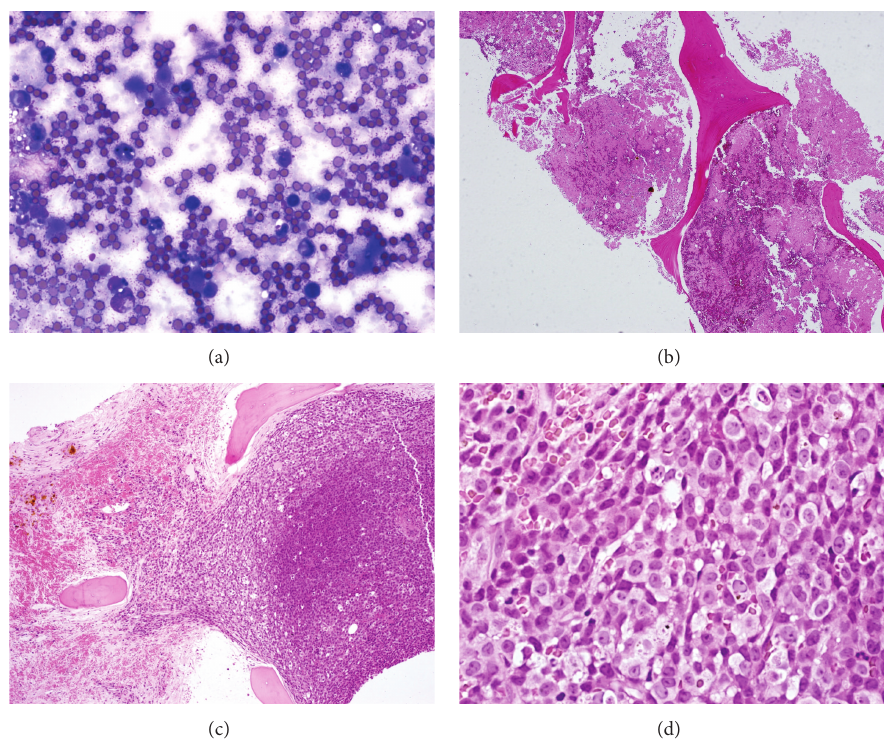
Figure 2: (a) Bone marrow aspirate showing necrotic cells with very rare intact cells. Note intense blue staining of necrotic cells. (b) Bone marrowtrephinebiopsyshowingmassivenecrosis.Notethehomogeneousstainingofthenecroticmarrow.(c)BMbiopsyshowshypercellular marrow due to a diffuse abnormal malignant infiltrate with starry-sky appearance. Note that areas of necrosis are still present. (d) The neoplastic cells show atypical large lymphoid cells with round, slightly irregular, or indented nuclei, dispersed chromatin, abundant agranular cytoplasm, and prominent nucleoli (blast-like